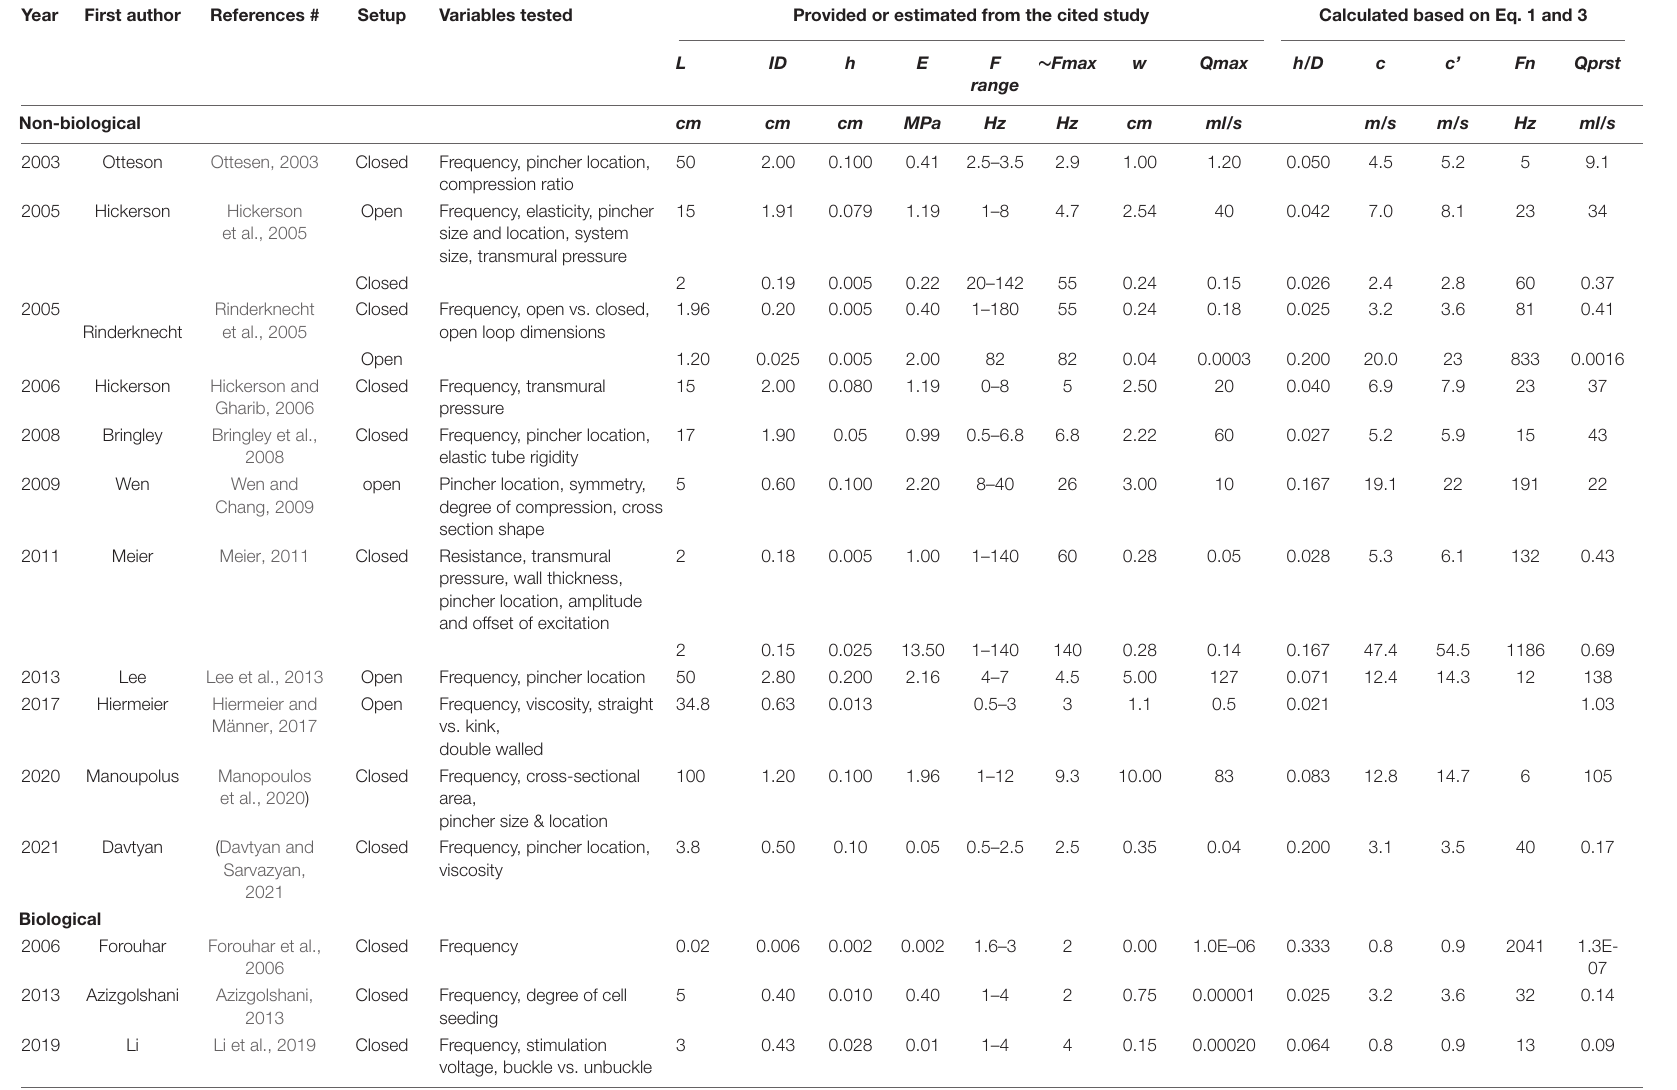
TABLE 2 | Flow rate values created by experimental variations of the Liebau